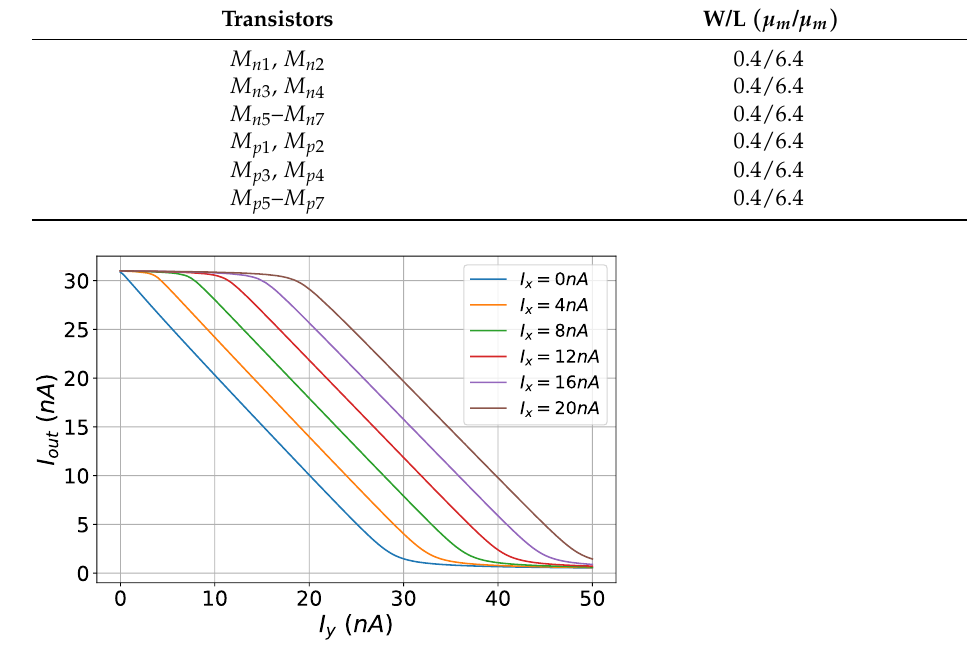
Figure 10. The output current of the adjuster